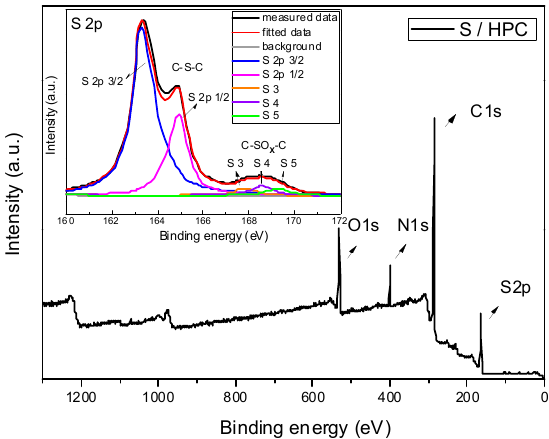
Figure 3. XPS spectra and high-resolution spectra of S 2p of S/HPC composite.